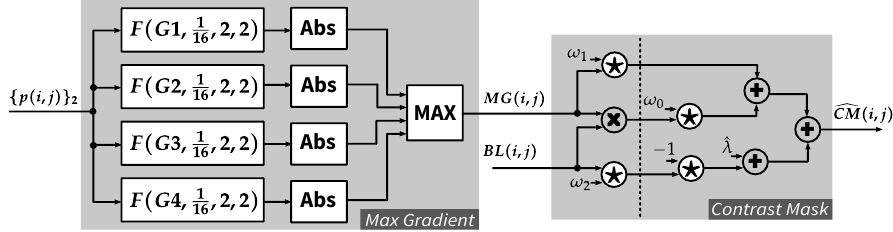
Figure 12. Contrast masking